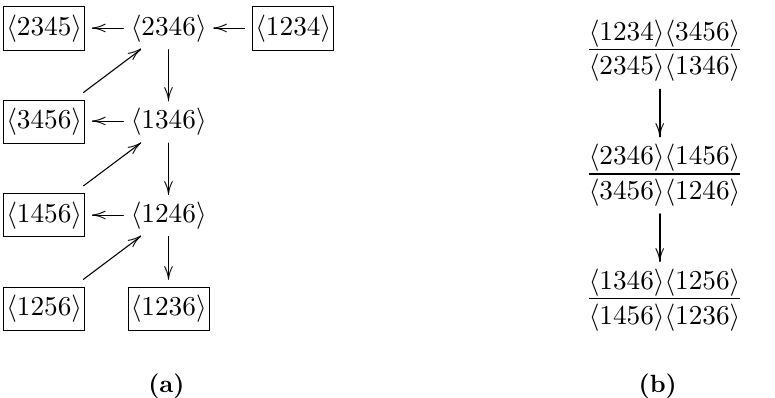
Figure 5. The A -coordinate seed quiver (a) and X -coordinate seed quiver (b) for Gr(4 ; 6). on these coordinates